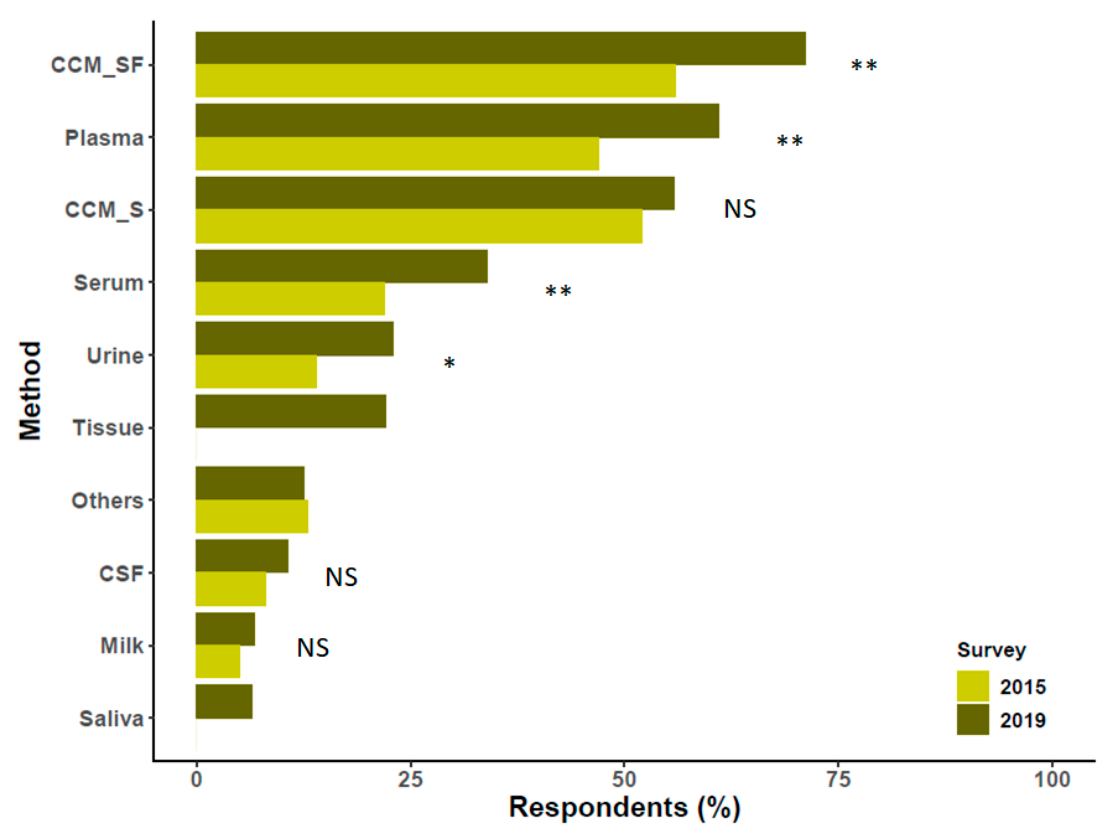
Figure 2. Sources of extracellular vesicles (EVs) and comparison with the report published previously by Gardiner et al. [8]. In the present survey (2019), there were 357 respondents to this question. Differences between proportions were tested by a z test, and p values were obtained by a chi-square test (NS, non-significant, * p < 0.05, ** p < 0.01. Missing bars: not queried in the 2015 survey). Please note that multiple answers were possible. Abbreviations: cell culture media enriched with serum